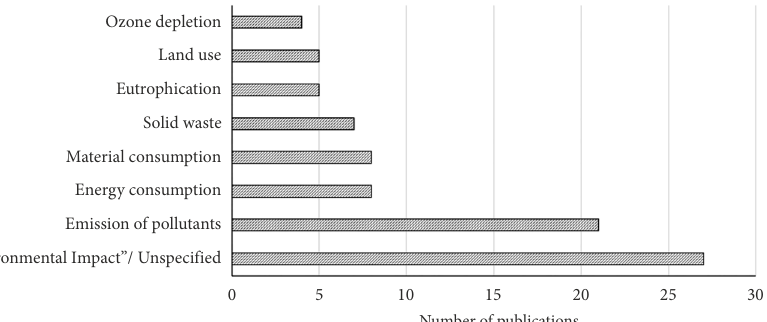
Figure 5. Environmental impact categories considered in the sustainability assessment of